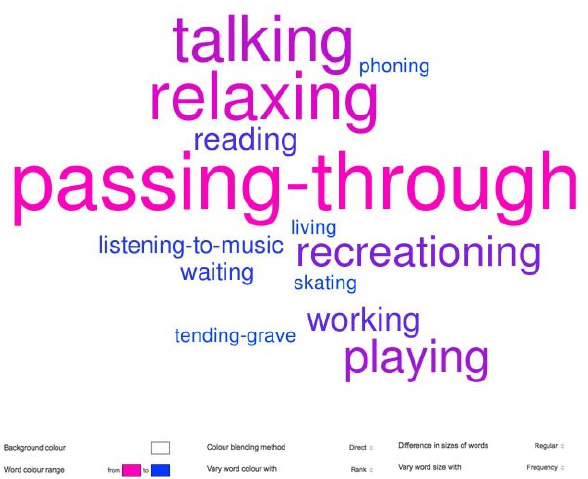
Figure 7: Word cloud representing the replies given to the question 2/section 2: What are people doing here? The size of the words varies according to the parameter: ”frequency” © A. Radicchi 2018